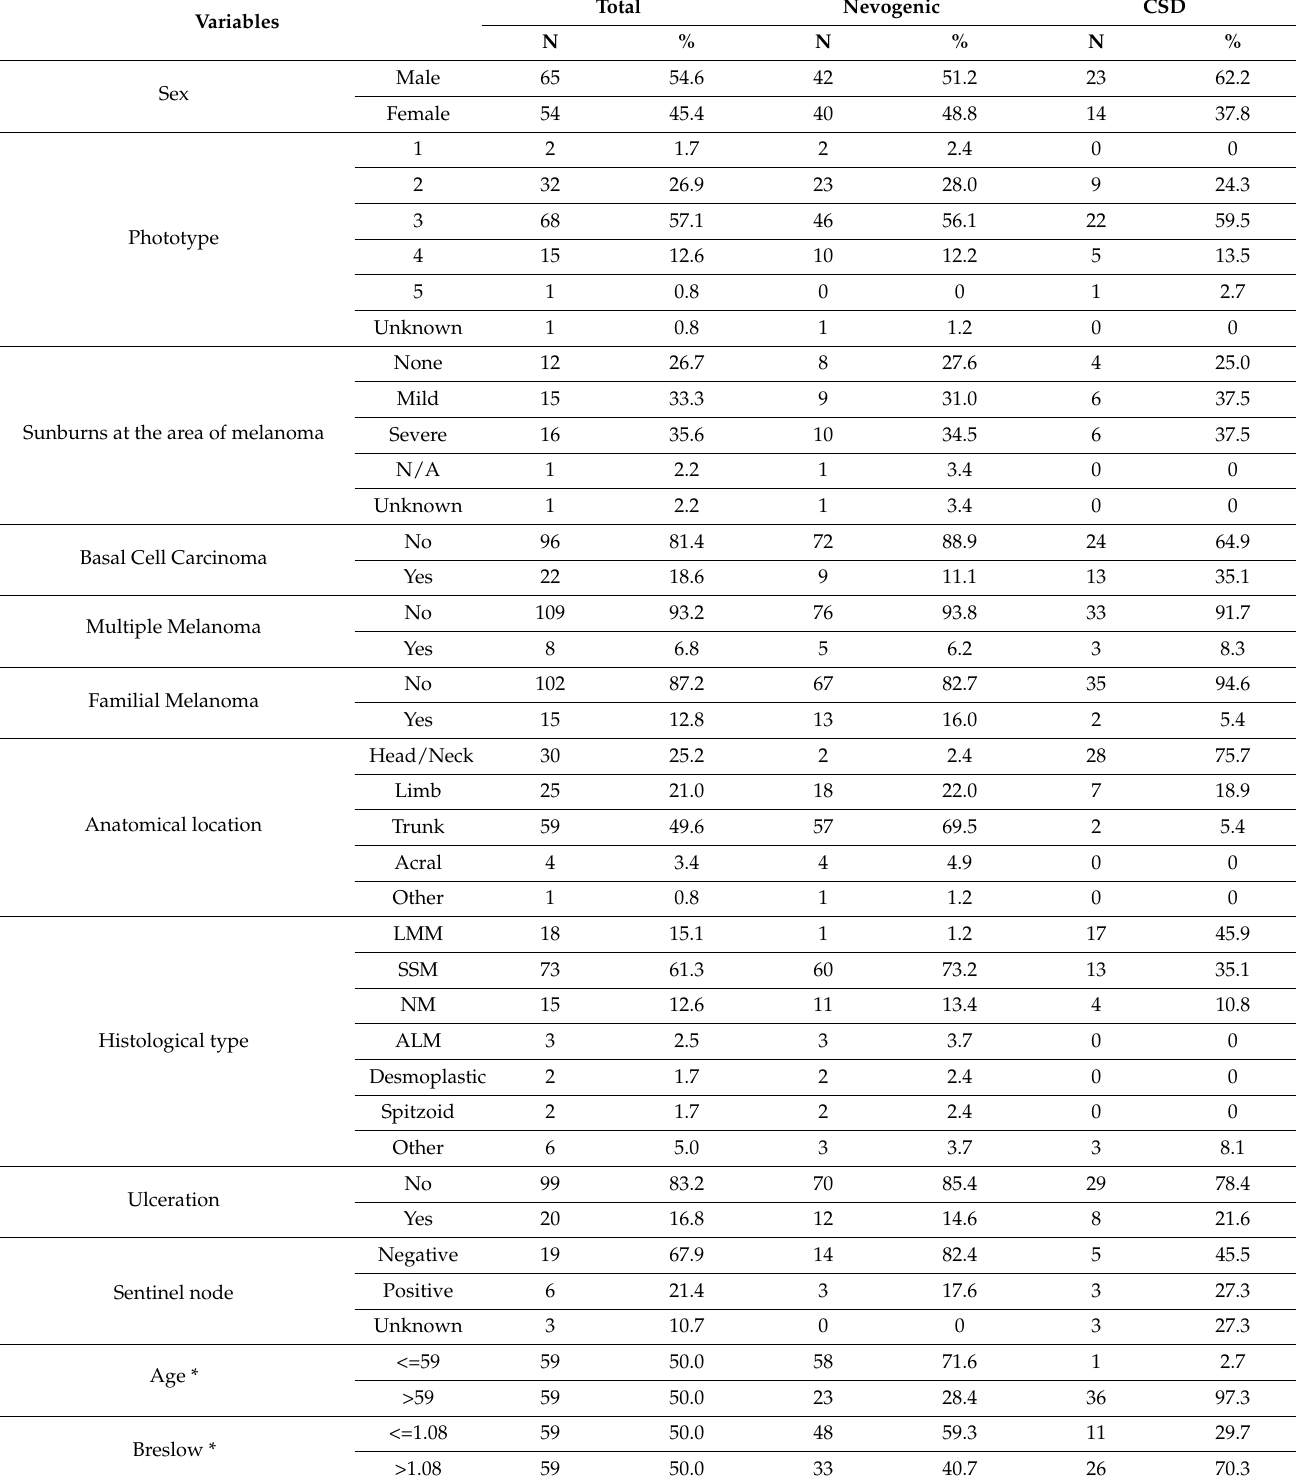
Table 1. Demographic and clinicopathological characteristics of the